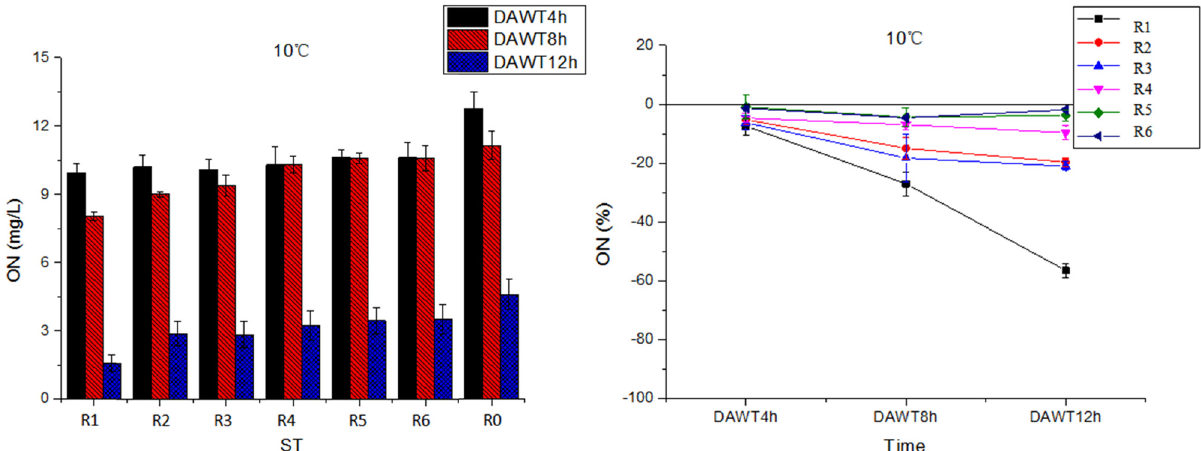
Figure 5: ON varies with